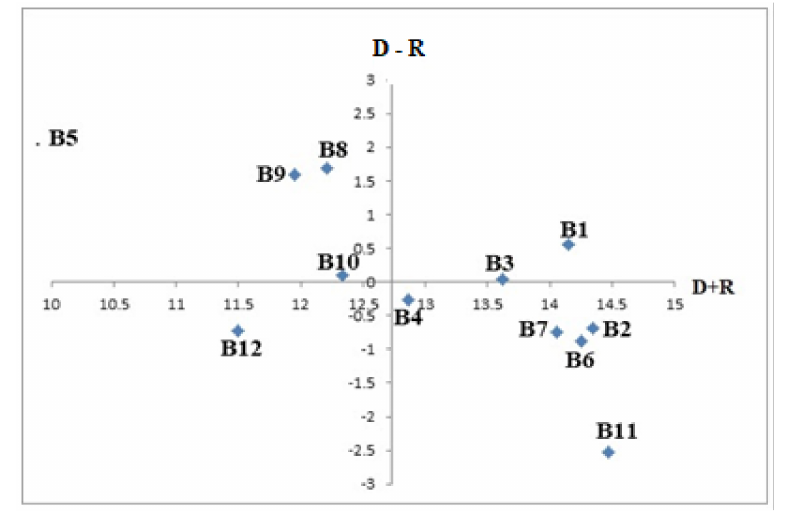
Figure 4. Cause–effect